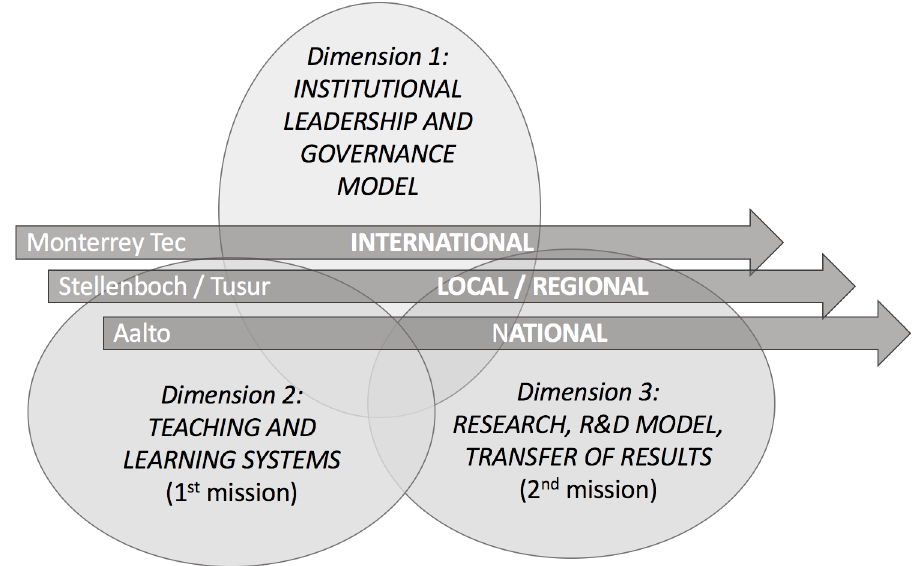
Fig. 4. Positioning of the analyzed universities in the dimensions of an IU. SOURCE: developed by the